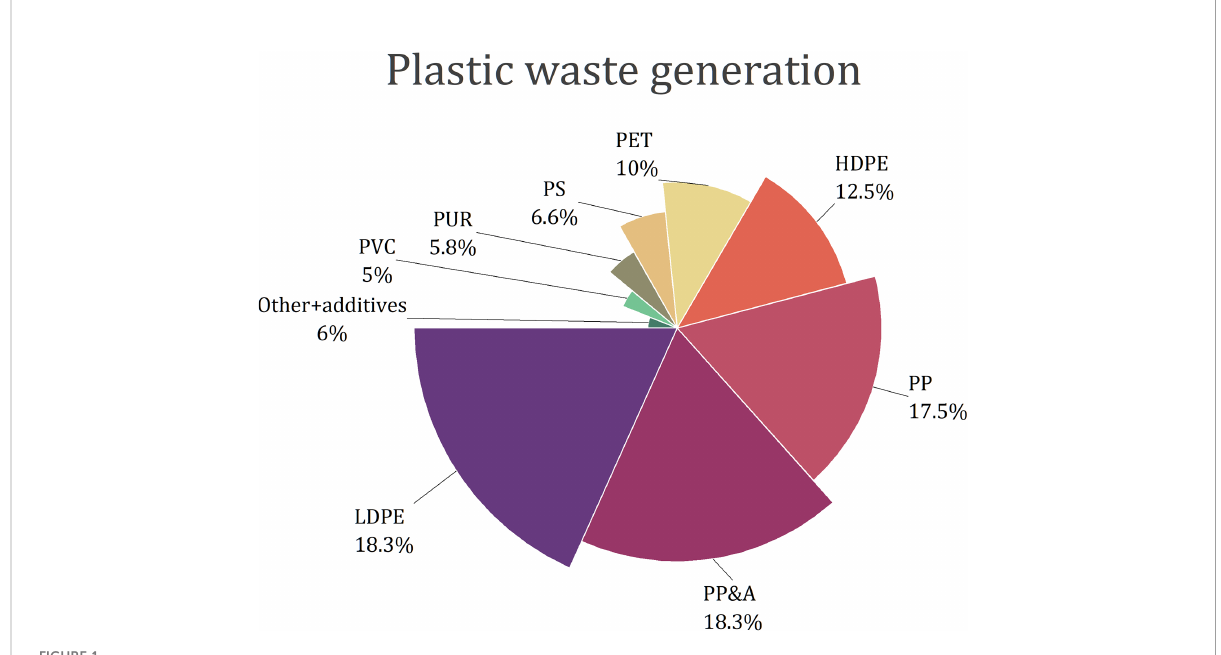
FIGURE 1 Composition of plastic waste generated globally in 2015 (Geyer et al.,